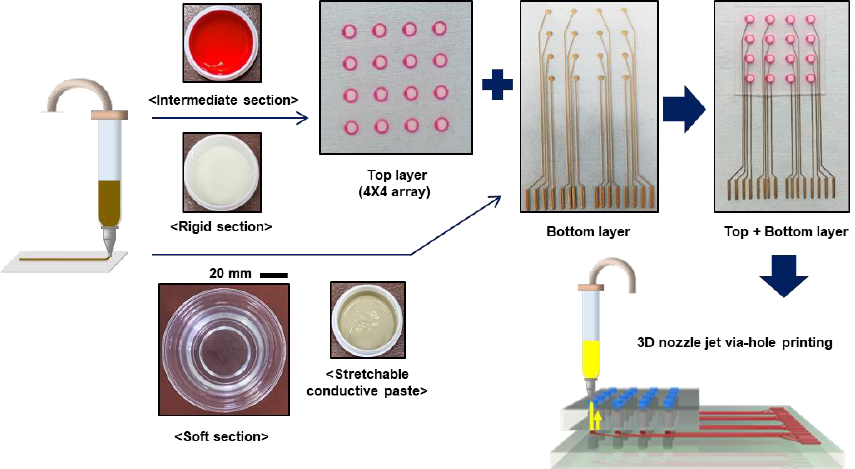
Figure 1. Schematic illustration of the manufacturing process for the double layer stretchable